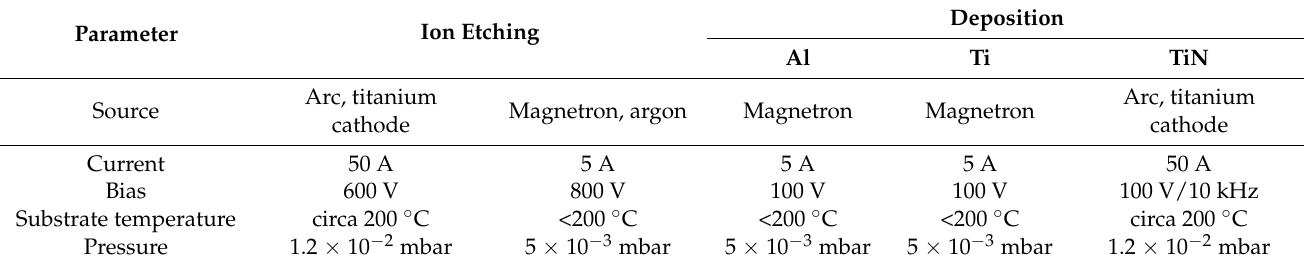
Table 2. PVD processes parameters used to produce the investigated